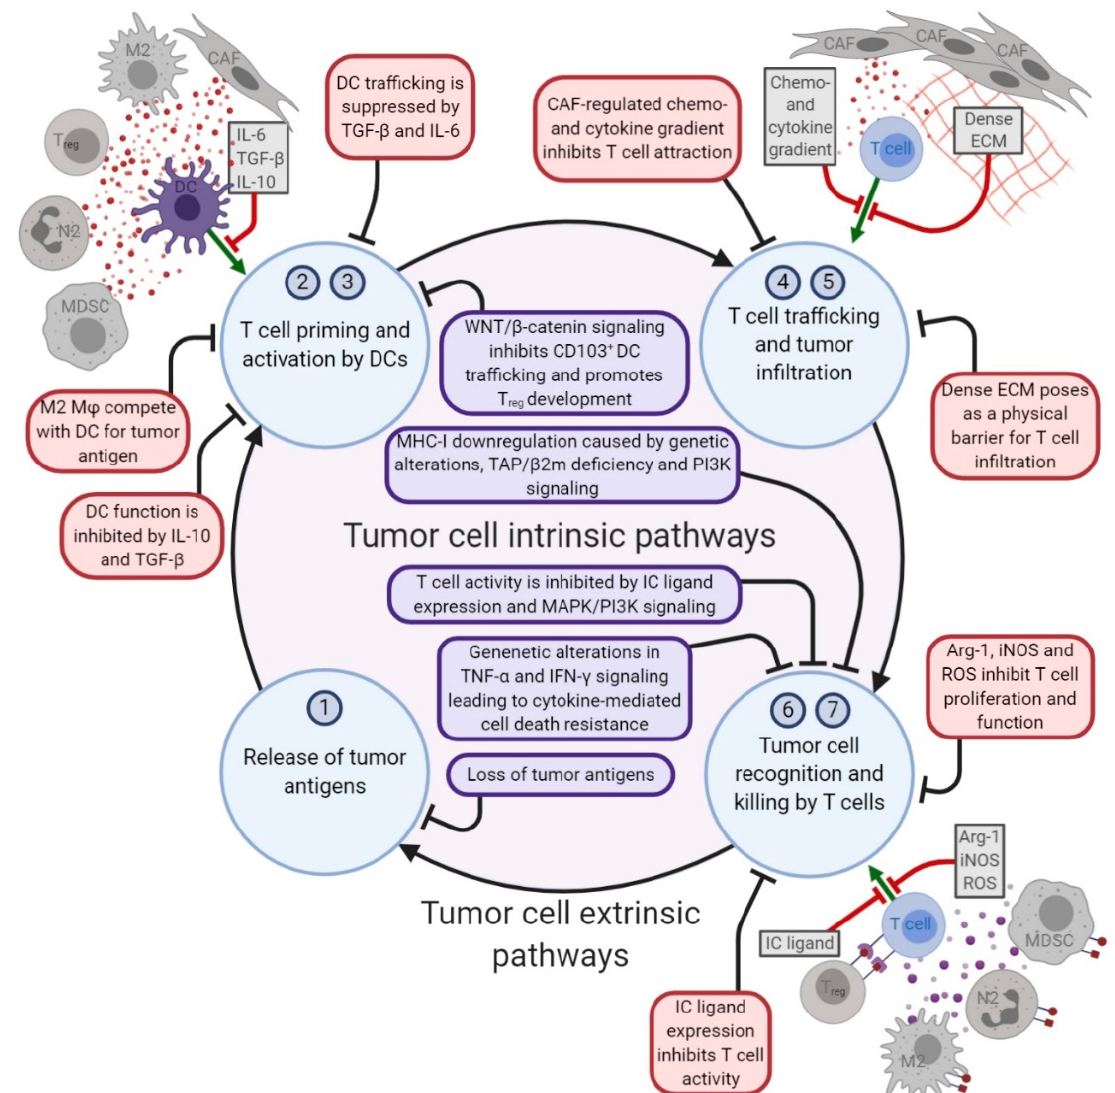
Figure 1. A simplified version of the cancer immunity cycle, adapted from Chen & Mellman [74] to show the tumor cell intrinsic and extrinsic pathways in T cell-based immunotherapy resistance. The numbers refer to steps in the original cancer immunity cycle. 1. The release of cancer cell antigens (cancer cell death); 2. Cancer antigen presentation (dendritic cells / APCs); 3. Priming and activation (Antigen Presenting Cells (APCs) & T cells); 4. The tra ffi cking of T cells to tumors (Cytotoxic T Lymphocytes (CTLs)); 5. The infiltration of T cells into tumors (CTLs, endothelial cells); 6. The recognition of cancer cells by T cells (CTLs, cancer cells); 7. The killing of cancer cells (immune and cancer cells). Created with BioRender.com.